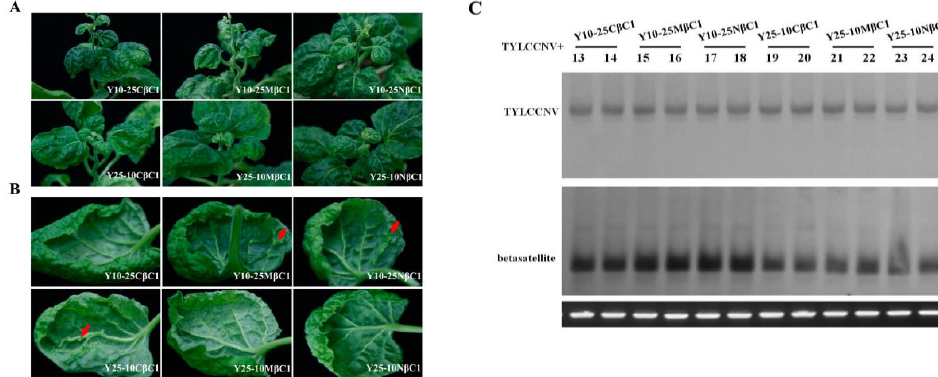
Figure 7. Symptoms induced by co-inoculation with TYLCCNV with hybrid betasatellites of TYLCCNB-Y10 and TYLCCNB-Y25 in N. benthamiana . ( A ) Whole plants. Photographs of plants were taken at 30 dpi; ( B ) abaxial leaf surfaces. Arrowheads indicate enations; ( C ) Southern blot analysis for viral DNA in N. benthamiana plants. The blots were probed either for TYLCCNV (top) or for betasatellite (bottom). The lower panel represents an ethidium bromide-stained gel of DNA samples as a loading control.